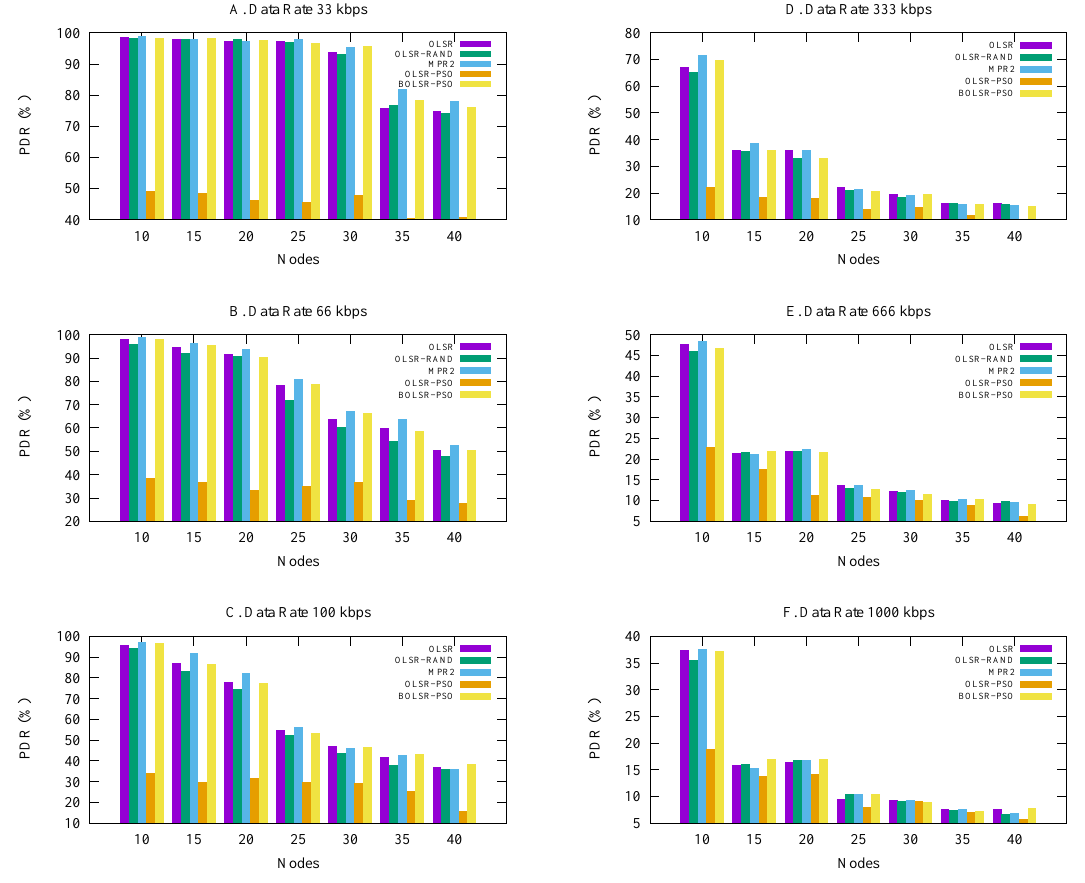
Figure 7. Packet Delivery Ratio vs. Number of Nodes.